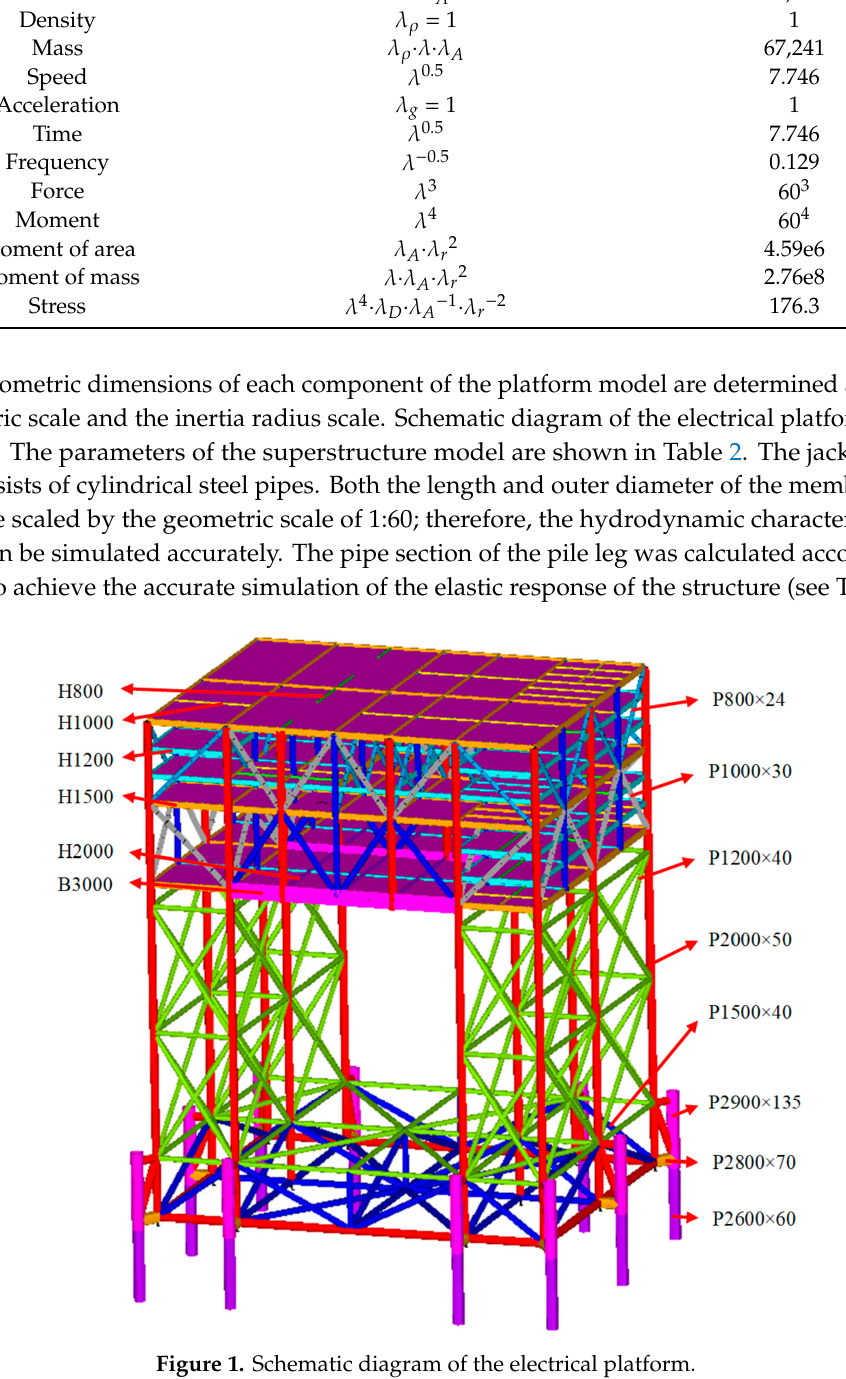
Table 1. The similarity relation of basic parameters for the experimental model design.